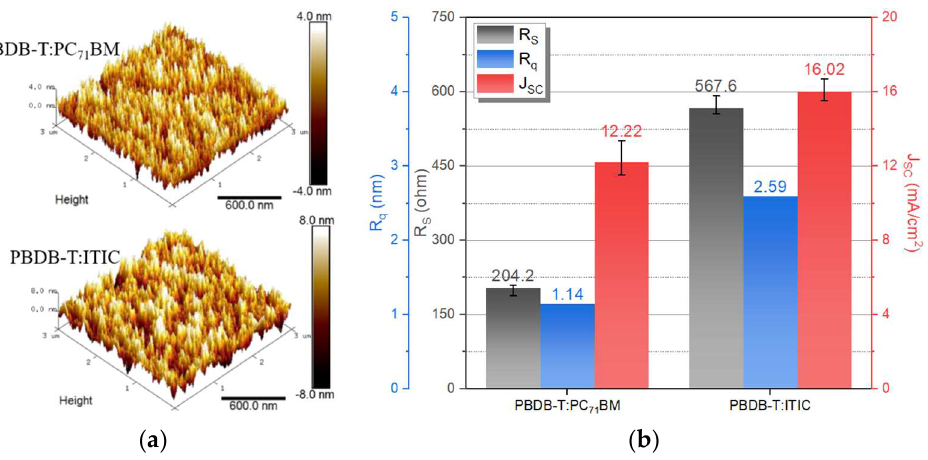
Figure 6. ( a ) AFM images of the organic active layer films, ( b ) average surface roughness (R q ), R S , and J SC with different acceptors (PC 71 BM and